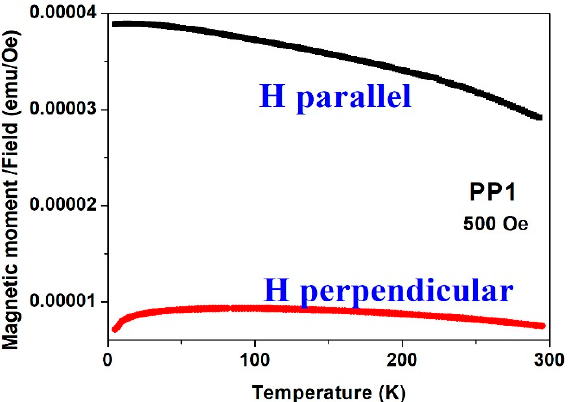
Figure 13. Perpendicular field dependence of the magnetic moments measured at 295 K for all DC and PP deposited quaternary Sn-Fe-Ni-Co alloy coatings.